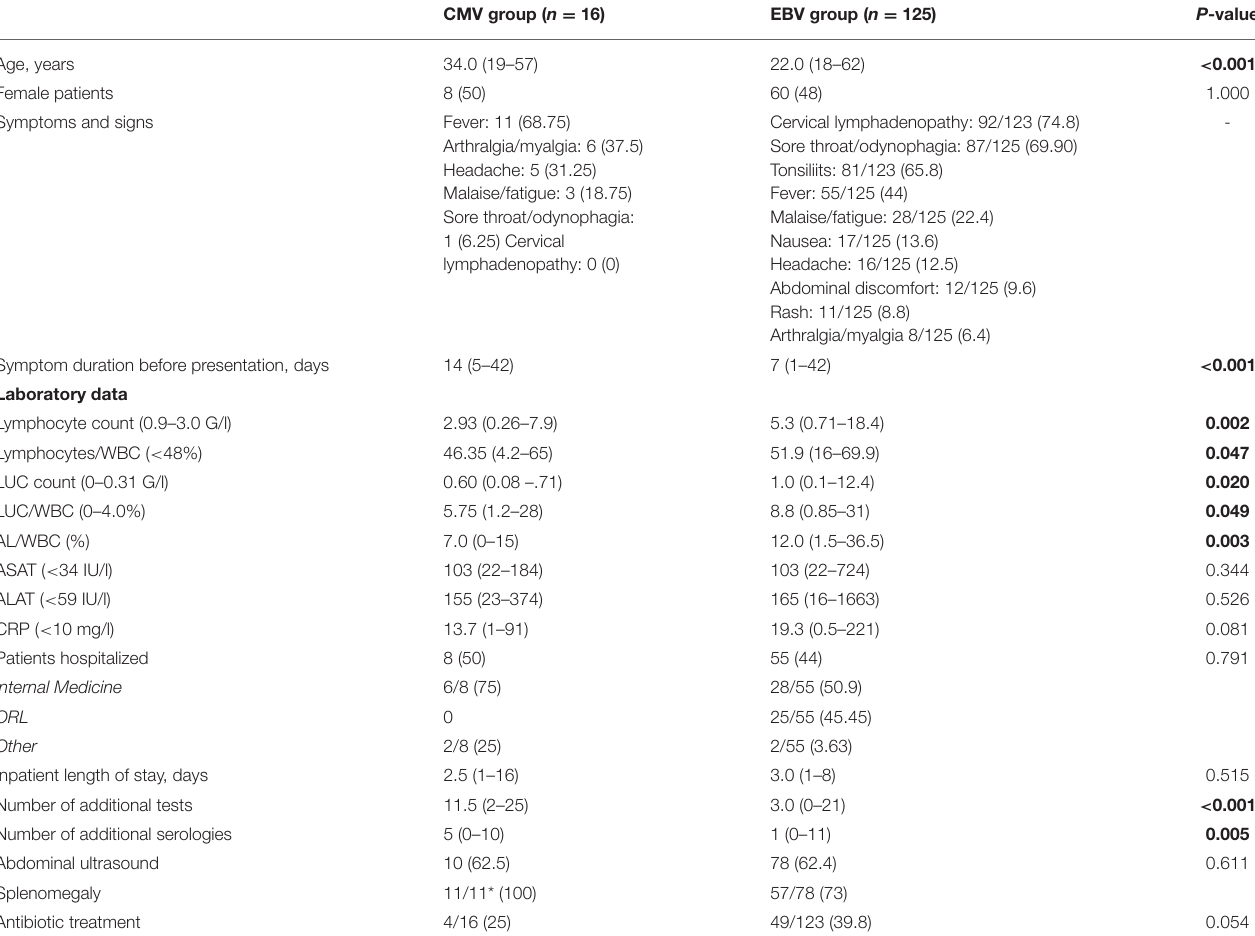
TABLE 1 | Comparison of patients’ characteristics, history, laboratory results and management of primary CMV vs. primary EBV infections. The data are reported as median (range) or n